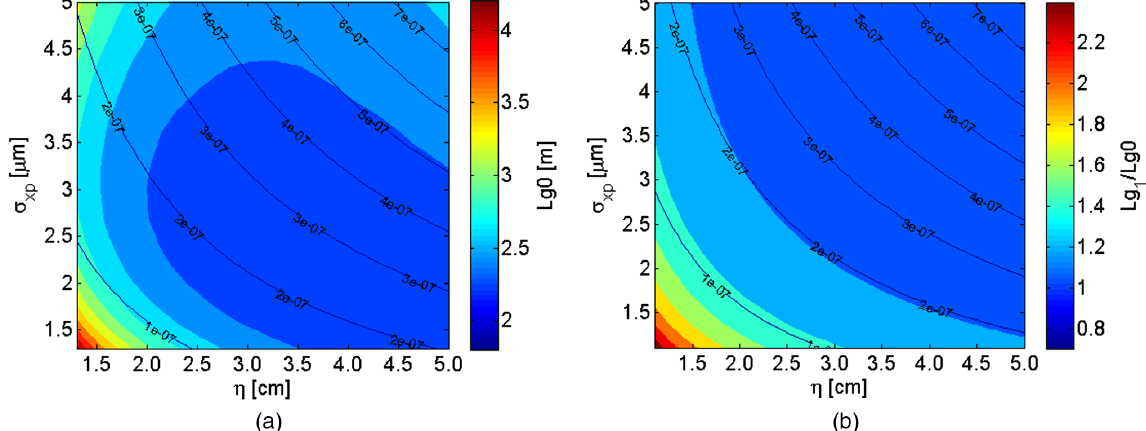
FIG. 6. (a) Gain-length Lg 0 of the main current peak and (b) gain-length ratio of side peaks to main current peak Lg 1 =Lg 0 in terms of different η and σ . The contour lines in both figures correspond to the current width τ , units in meters. x 0